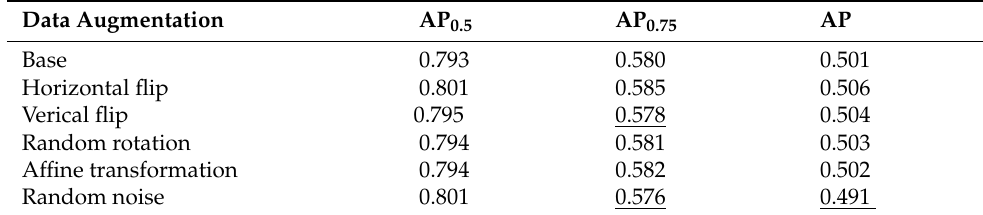
Table 5. Influence of using different data augmentation methods on the 10% labeled dataset. Data Augmentation